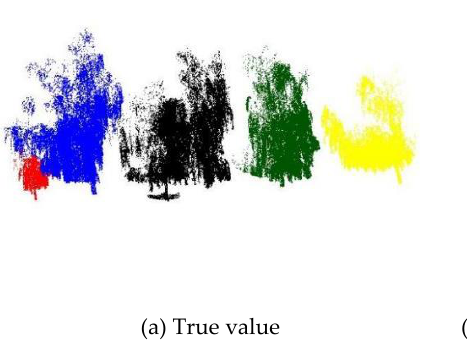
Figure 15. Willow under segmentation